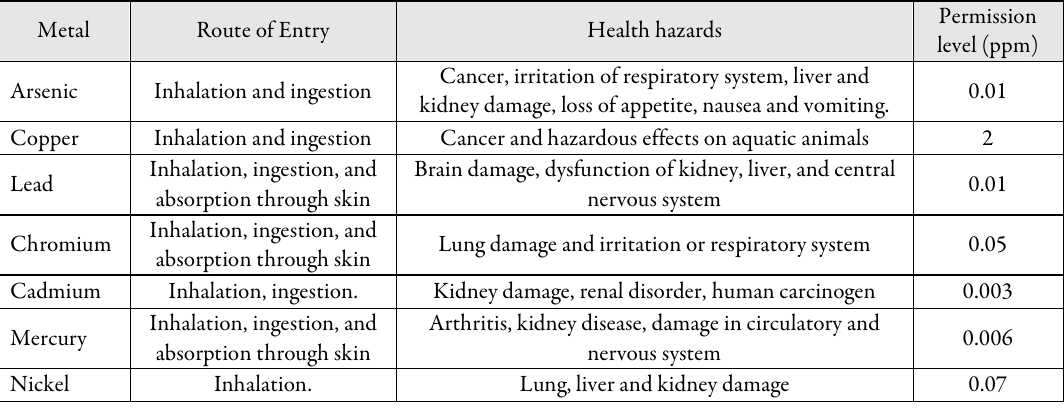
Table 1. Routes of entry, hazardous effects and standard permissible concentrations of some metal ions (Barakat 2011), (Sheth et al ., 2021), (Sarode et al .,